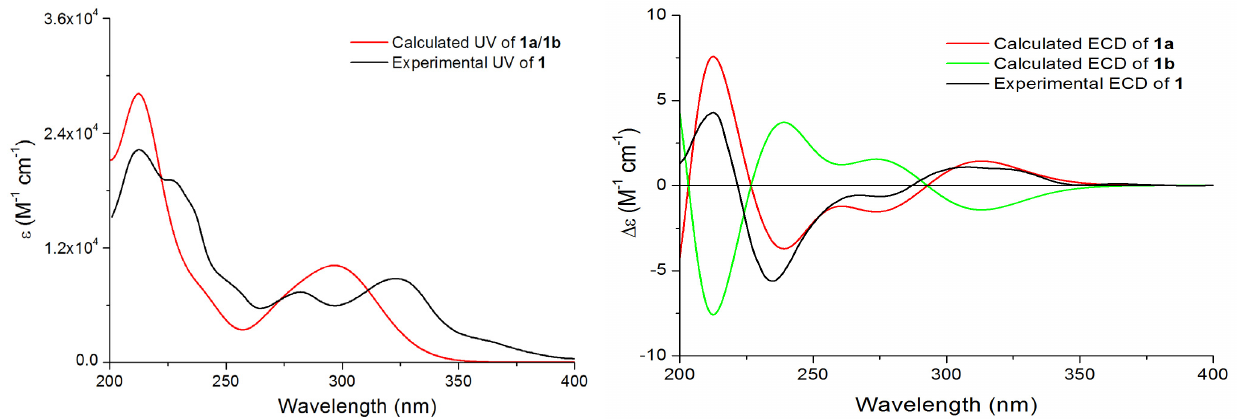
Figure 4. Experimental UV and ECD spectra of 1 , and calculated and ECD spectra 1a and 1b